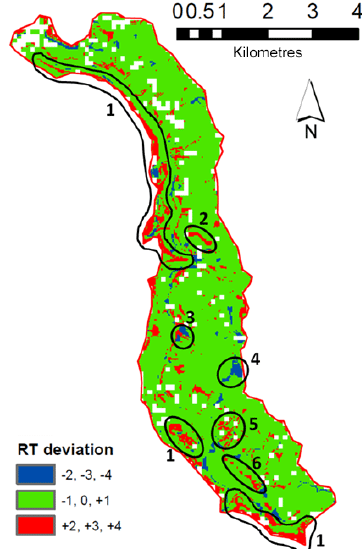
Figure 8. Deviation map between the MU09 map and the reference map. In the numbered areas the runoff contribution was either over- estimated (red) or underestimated